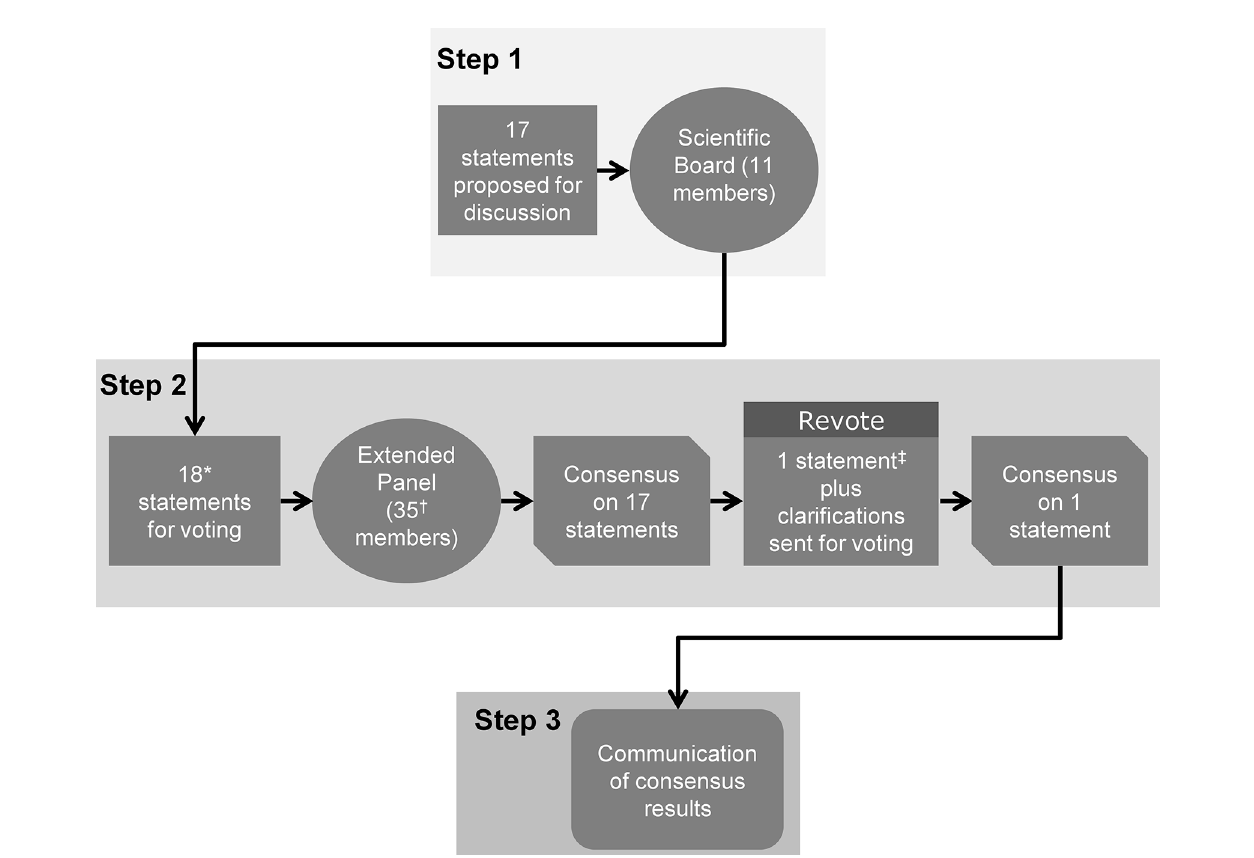
FIGURE 1 | The three steps of the Delphi consensus process. The consensus comprised three steps. Step 1: Statements and supporting references initially developed by the Scienti fi c Coordinator were discussed and amended by the 11 members of the Scienti fi c Board. Step 2: An extended panel of 35 experts voted on their level of agreement or disagreement with each statement. Step 3: The consensus results were communicated to the participating experts. *One new statement (Statement 18) was added during Step 1, following disagreement on the wording of Statement 17; † 28/35 (80%) of panel members completed the entire